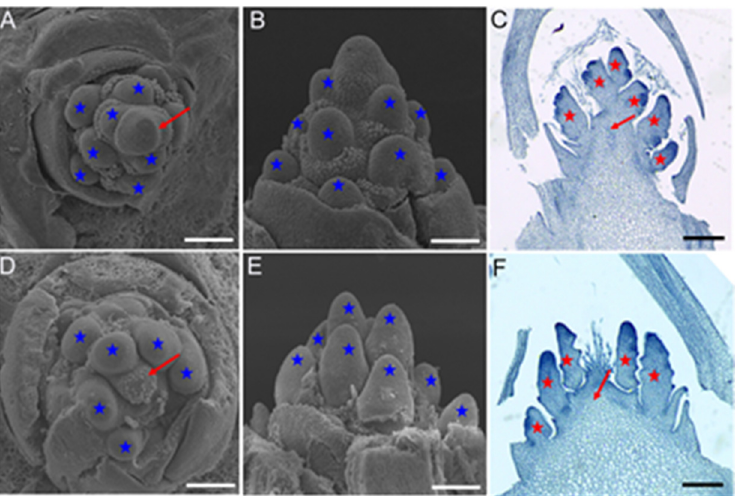
Figure 2. Morphological analysis of wild-type and vpb1 inflorescence. ( A – B ) Scanning electron microscope (SEM) images of PBMs at their initiation stage in wild-type. ( D – E ) Scanning electron microscope (SEM) images of PBMs at their initiation stage in vpb1 mutant. ( C , F ) Paraffin section images showing the inflorescence of the wild type ( C ) and vpb1 ( F ). The arrow and asterisks indicate inflorescence and primary branch meristems, respectively. Scale bar, 100 μ m.